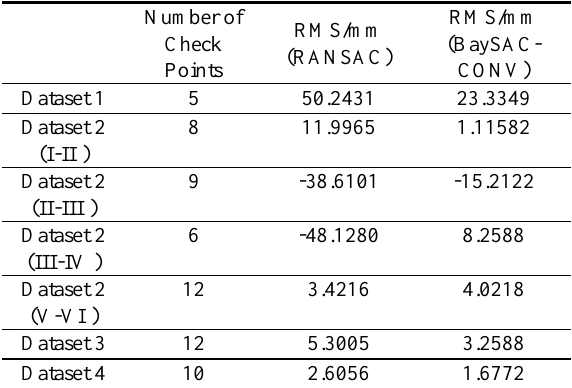
Table 2. The evaluation of registration accuracy in terms of the average point-to-point